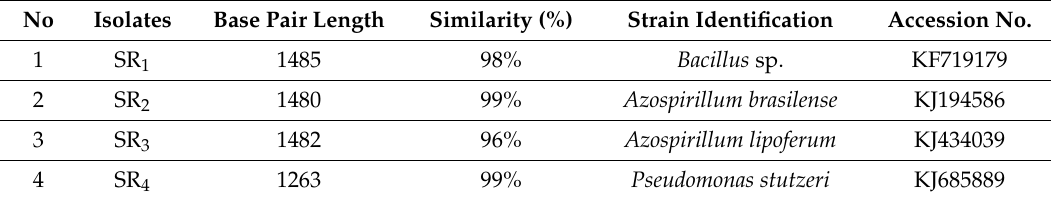
Table 2. Molecular identification of the isolates based on partial 16S rDNA